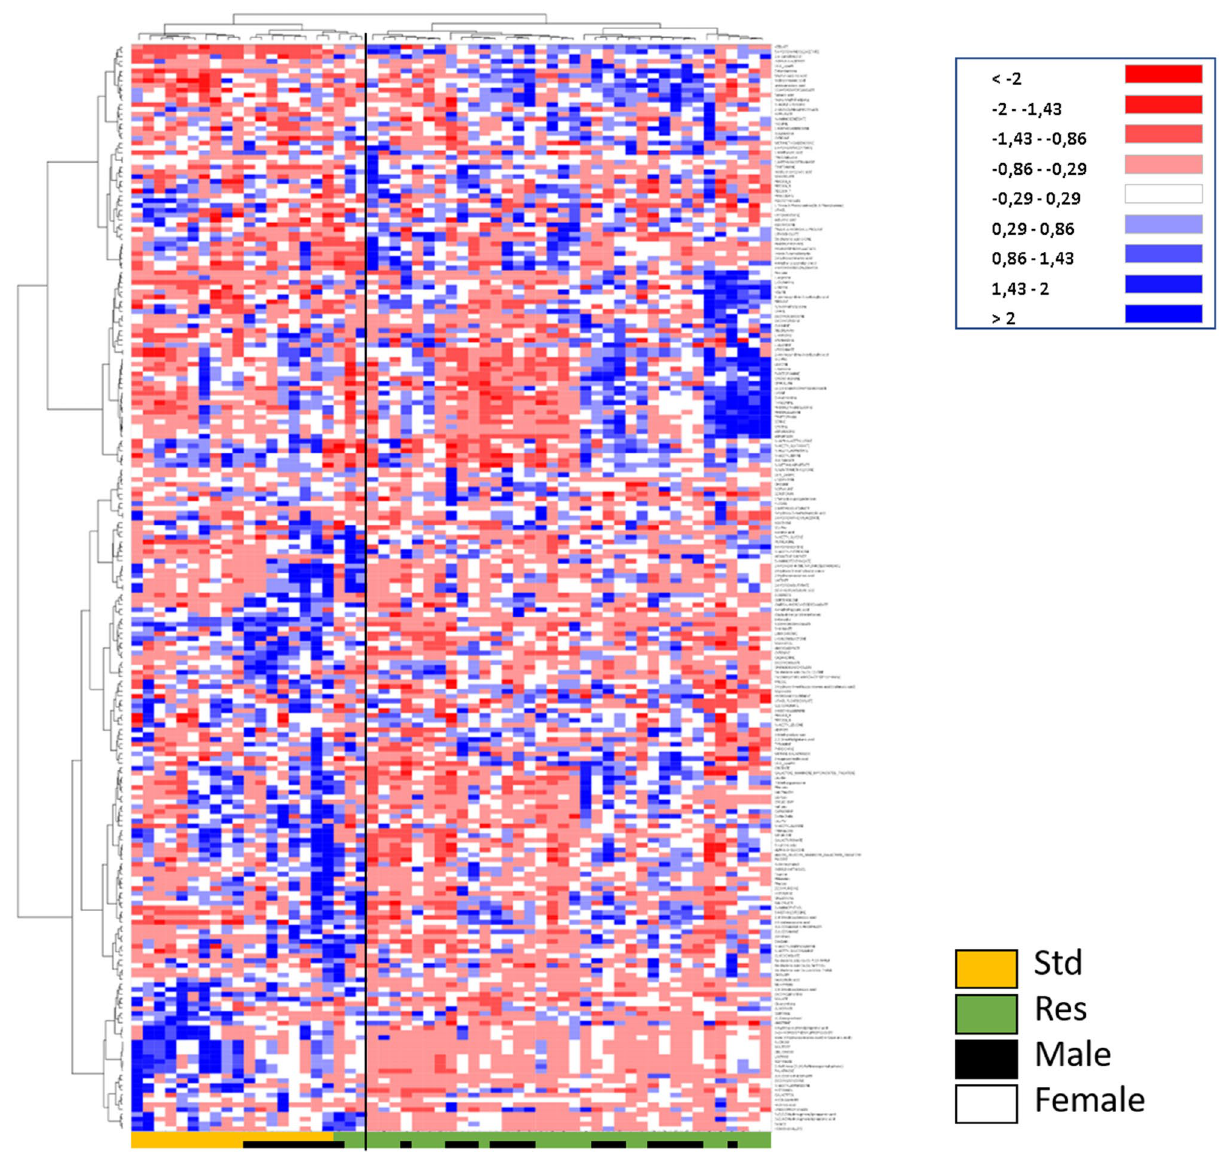
Figure 2 . Heat Map, i.e. hierarchical clustering of fecal metabolomes from Std (orange) or Res (green) rats. Rats are on the ordinate where black squares note males. Fold-change for each metabolite (abscissa) is represented by a color. Intensity values are normalized, from red (Min: − 2) to blue (Max: +